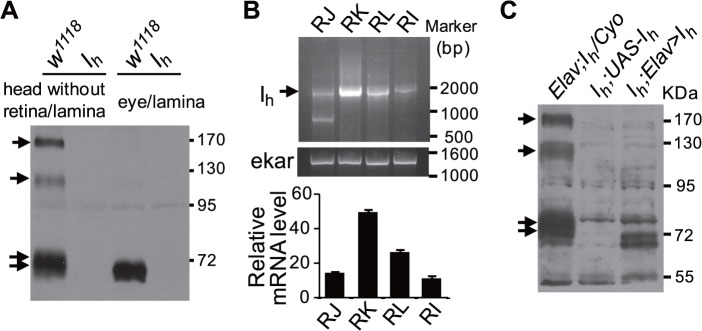
Transcriptional and translational profiles of Ih channels.(A) Western blotting shows the Ih variants expressed in isolated retina/lamina and head without retina/lamina. Each lane was loaded with retina/lamina or head without retina/lamina from two flies. The Ih channel bands are indicated with arrows. (B) RT-PCR shows the transcriptional profile of Ih channels (arrow) in the isolated retina/lamina. Primer pairs used to amplify each transcriptional variants are I
h-RJ: GGCACCGCTTGTCACTGCTC/GGATCGAAAGTTGGAGCG; I
h-RI: GGCACCGCTTGTCACTGCTC/CTAGACCAGGACAGACAGAC; I
h-RL: GGCACCGCTTGTCACTGCTC/GCACGCTTCCAGACTTCTACG; I
h-RK: GGCACCGCTTGTCACTGCTC/GCCAGCCAATTTCGGAAGCG. Quantification of relative transcriptional variants of the I
h gene in the isolated retina/lamina is shown at the bottom. The ekar gene was used as a loading control. (C) Expression level of Ih channels in rescue flies. A single copy of the GAL4 driver was used. The Ih channel bands are indicated with arrows.